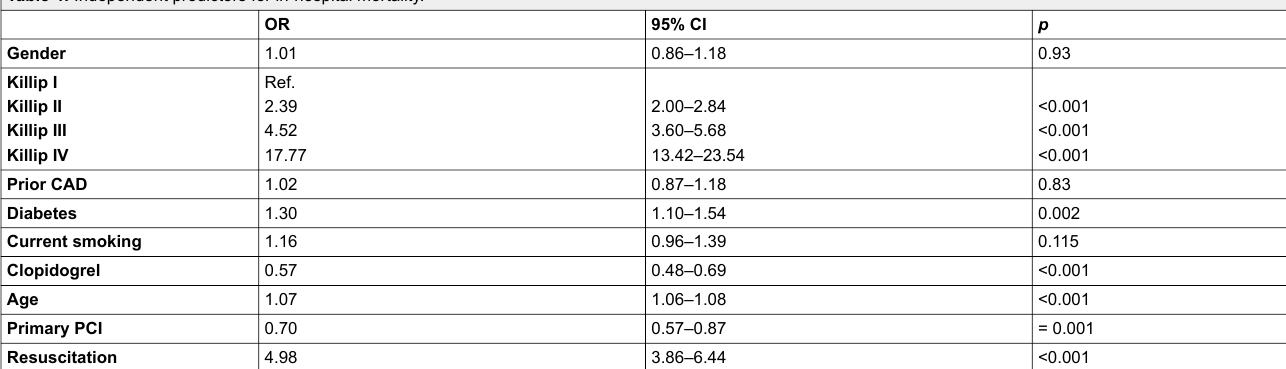
Table 4: Independent predictors for in-hospital